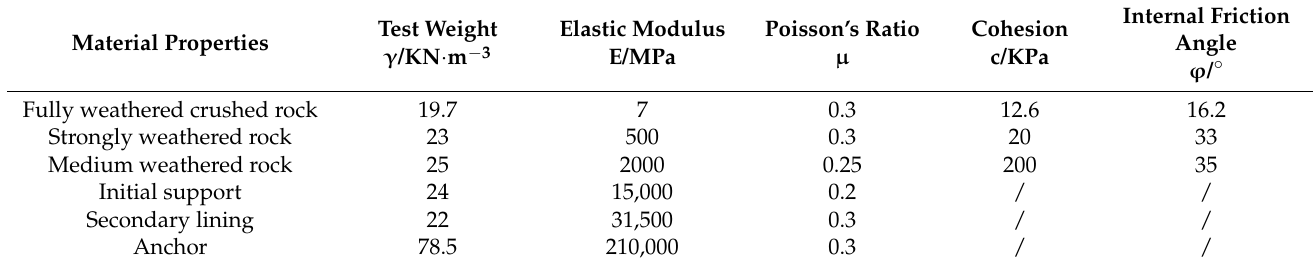
Table 2. Material physical and mechanical parameters.